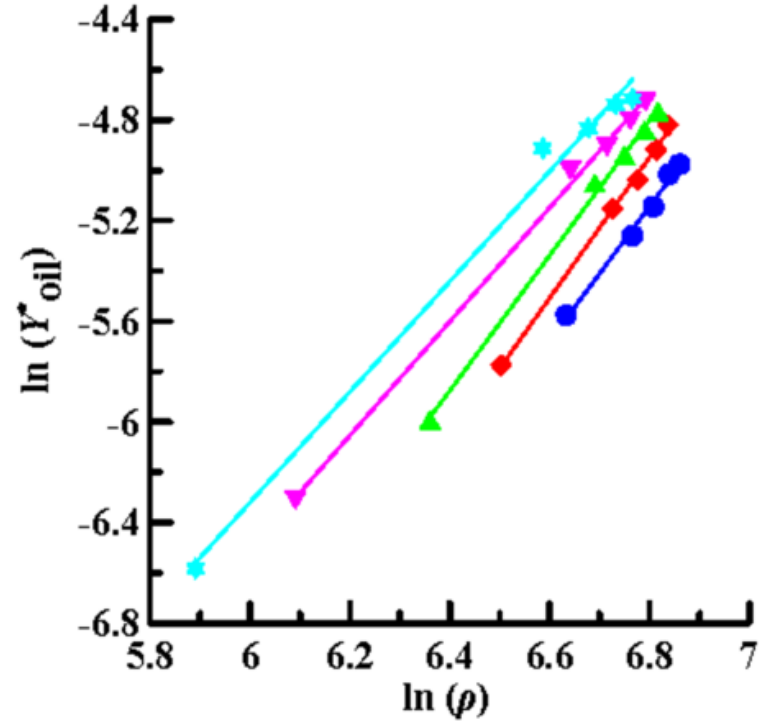
Figure 4. Plots of ln ( Y * oil ) versus ln ( ρ ) using the Chrastil model for oil extraction from P. frutescens leaves at various temperatures and pressures of 10.5–33.0 MPa. ( • :32 ◦ C; (cid:117) : 38 ◦ C; (cid:78) : 43 ◦ C; (cid:72) : 49 ◦ C; (cid:70) : 55 ◦